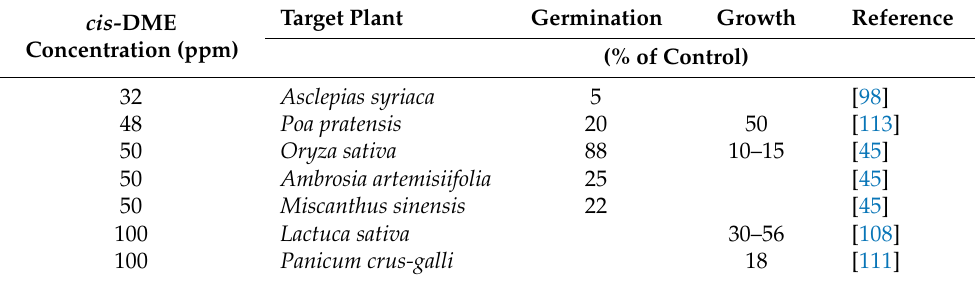
Table 3. Growth inhibitory activity of cis -dehydromatricaria